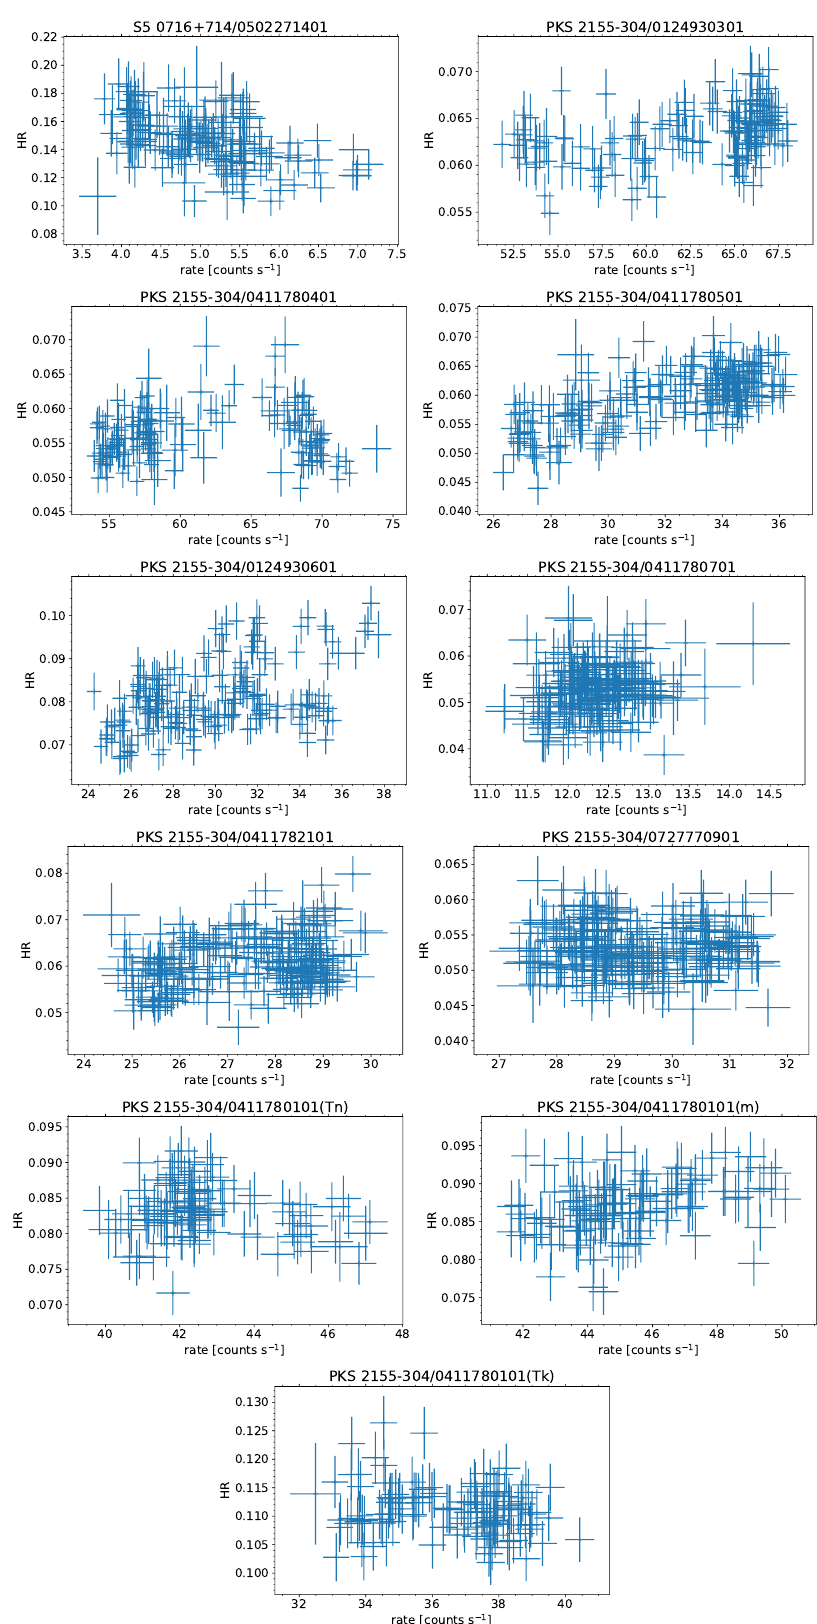
Figure 2. HR as a function of 0.3–10 keV count